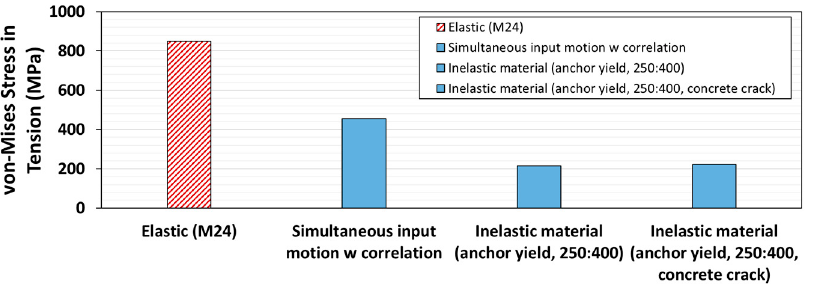
Figure 23. Maximal von-Mises stress variations of the anchor: results of elastic and inelastic time history analyses.